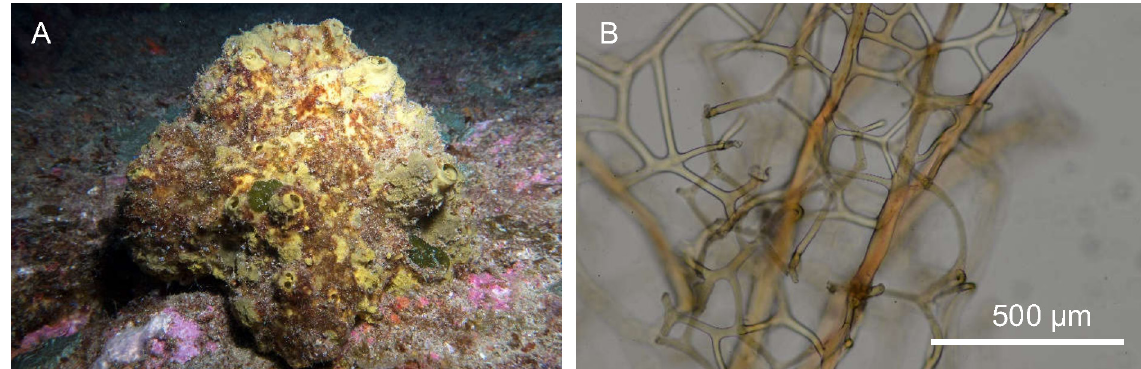
Fig. 4. Hyattella sulfurea Calcinai & Belfiore sp. nov. A . Holotype MSNG 61417 in situ . B . Network of primary